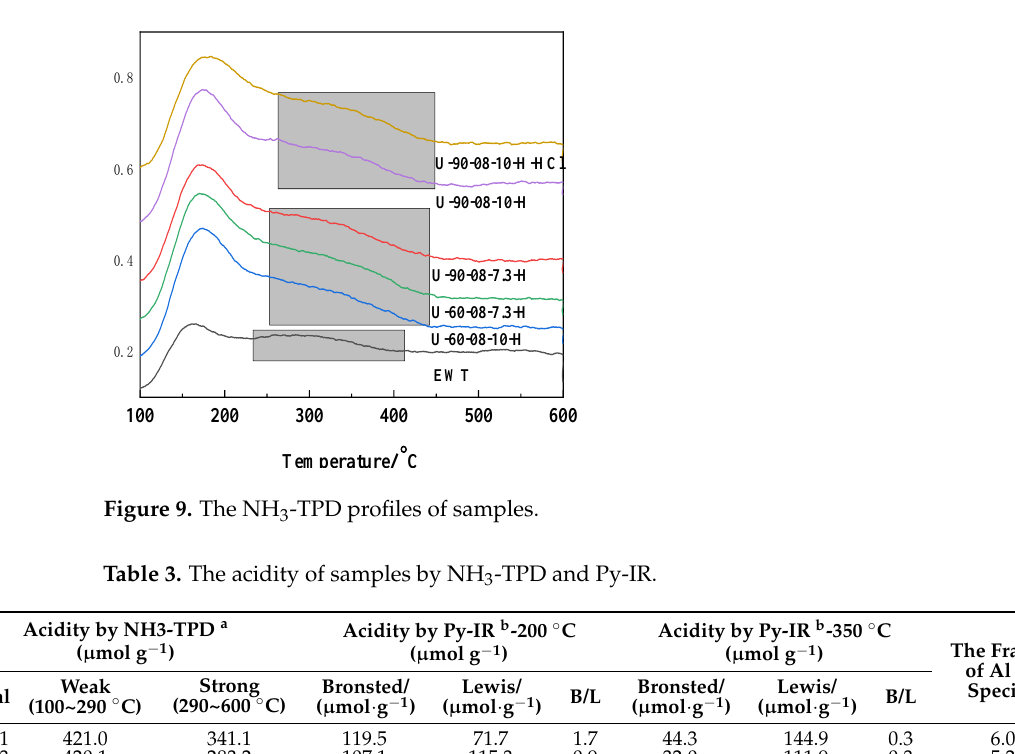
Table 3. The acidity of samples by NH 3 -TPD and Py-IR.